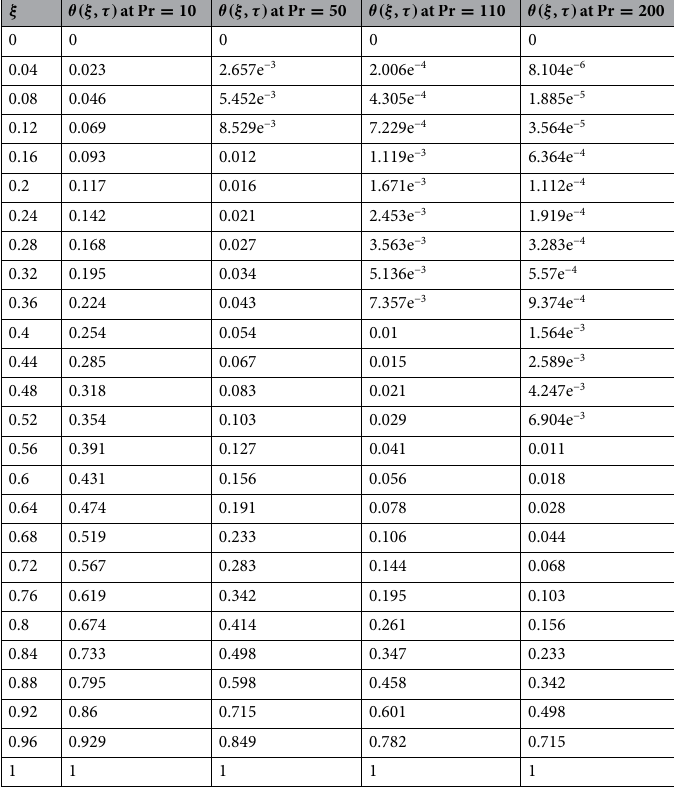
Table 11. Variations in temperature profile against ξ if f (τ) = 1 for different values of Pr